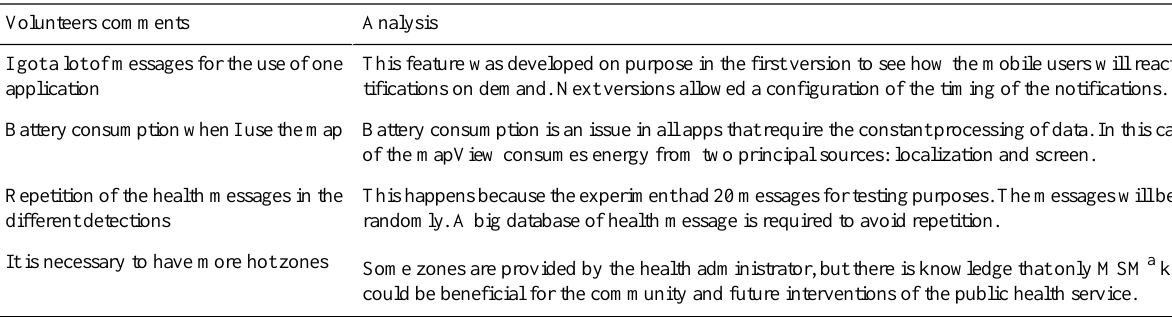
Table 2. Perceptions of volunteers in the functional